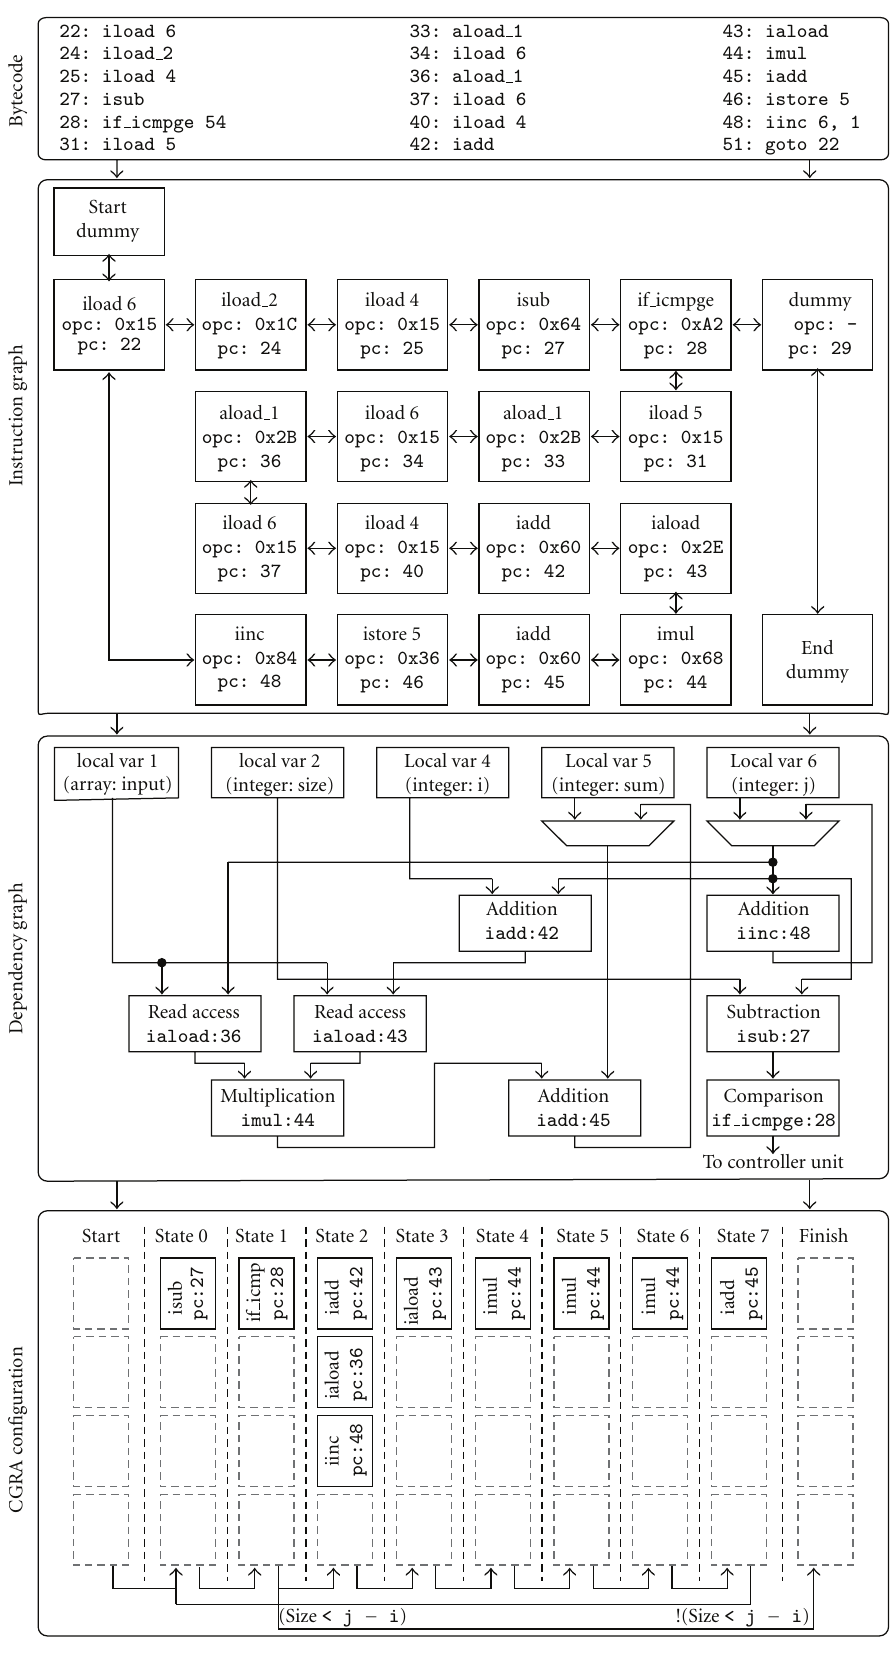
Figure 6: Example of intermediate synthesis